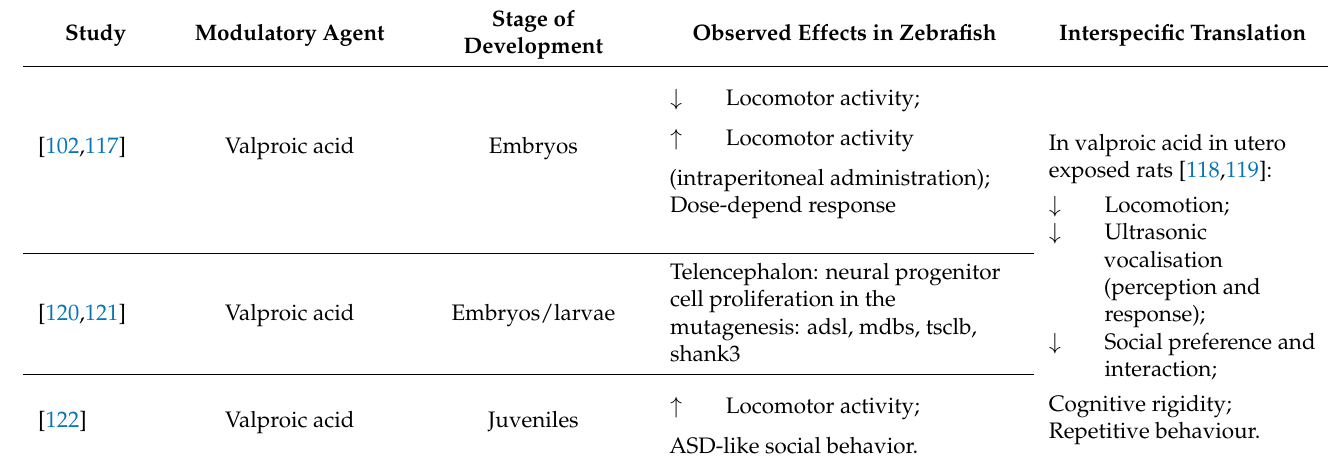
Table 2. Toxicological and phenotypical studies conducted on zebrafish